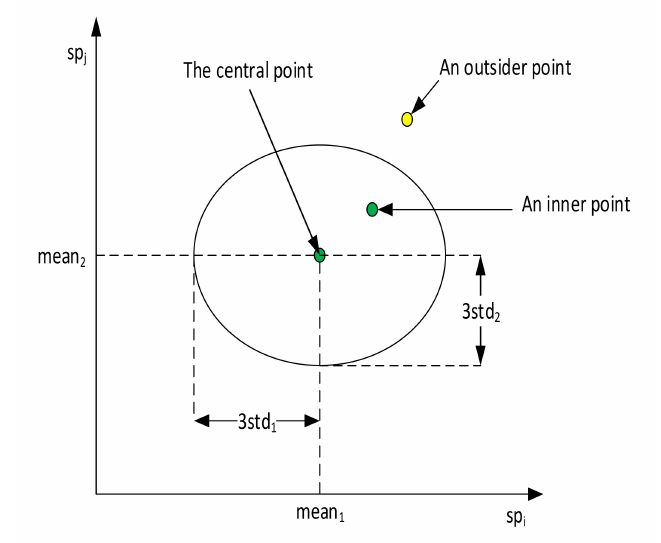
Figure 4. The illustration of how to classify data